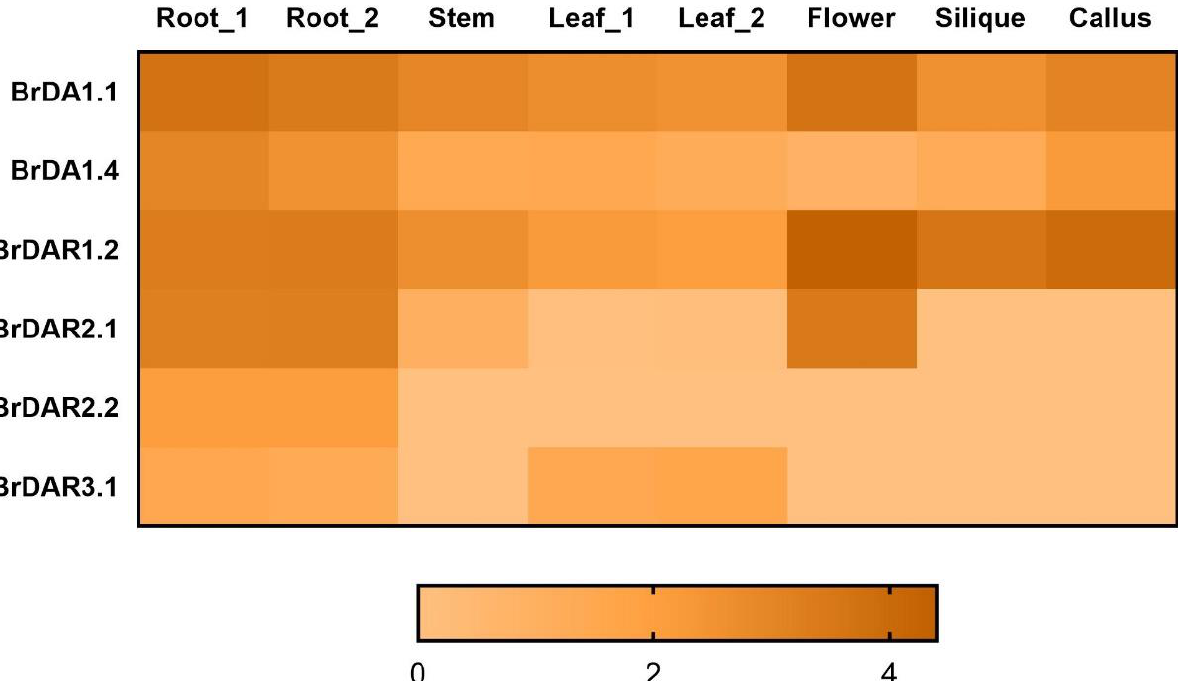
Figure 7. Heatmap presentation of BrDA1 & DARs genes expression in various tissues (root, stem, leaf, callus, flower, and silique). The bar at the bottom presents the expression value.